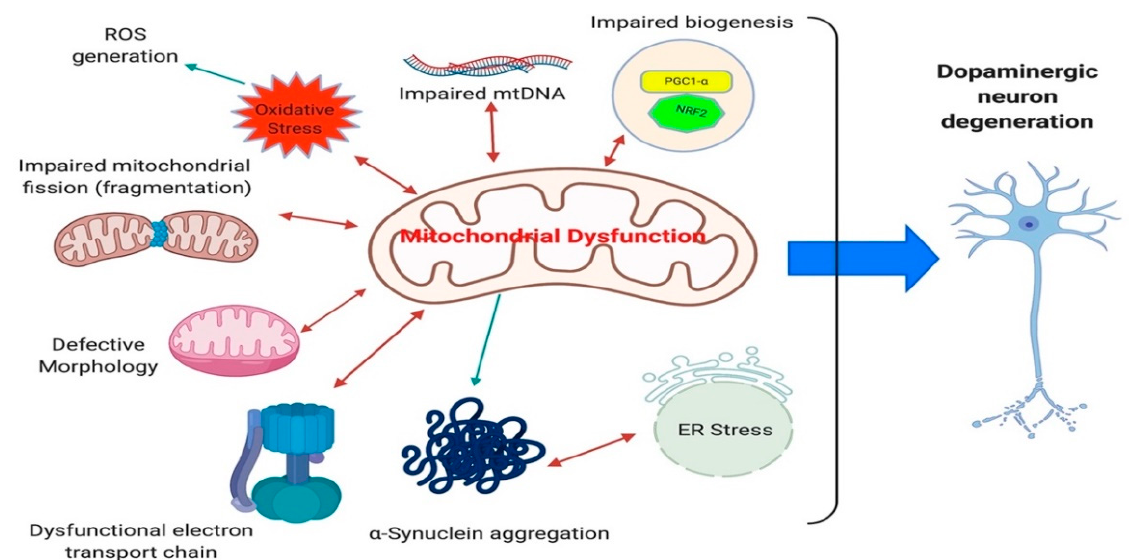
Figure 4. Pathways of mitochondrial dysfunction, a major cellular and clinical phenotype in PD. Mitochondrial dysfunction can result from impairment in mitochondrial fission, change in mitochondrial morphology, electron transport chain, increase in mtDNA, elevation in oxidative stress leading to reactive oxygen species generation, alteration in mitochondrial biogenesis and electron transport dysfunction. These can lead and associated with protein aggregation and eventual endoplasmic (ER) stress that ultimately results in degeneration of dopaminergic neurons that underlines the PD pathogenesis.